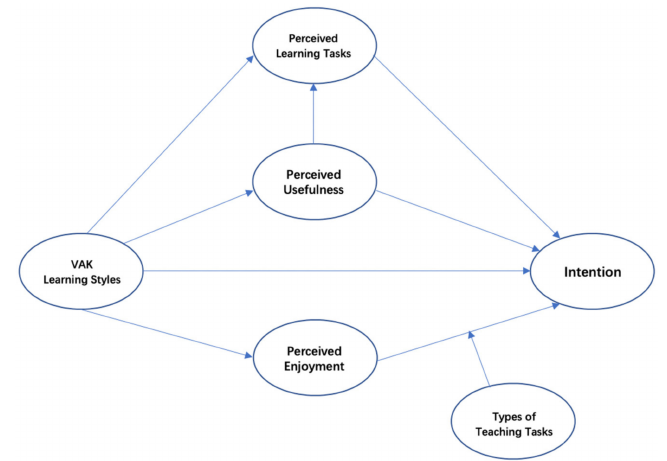
Figure 1. Theoretical